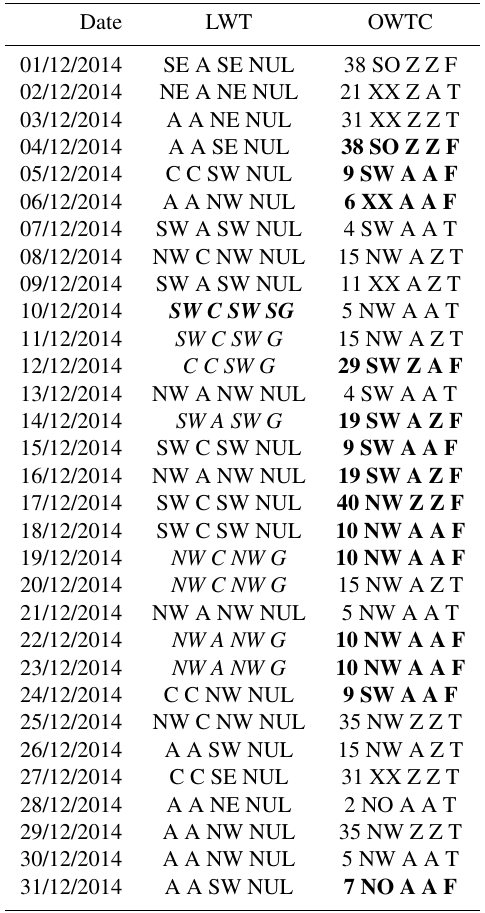
Table 1. Modified Lamb weather types (LWT; BSH) and objec- tive classification (OWTC; DWD), December 2014. Letters in the LWT column indicate the following from left to right: the classi- fied weather type, cyclonality index (A or C), predominant wind direction at ground level, and gale index. Characters in the OWTC column indicate the following from left to right: weather type num- ber, predominant wind direction at 700hPa, cyclonality (A or Z) at 950 and 500hPa, and humidity index (T or F). LWT gale indices are printed in italic (gale) and bold and italic (severe gale) letters; OWTC wet weather types are given in bold letters. “NUL” indicates no